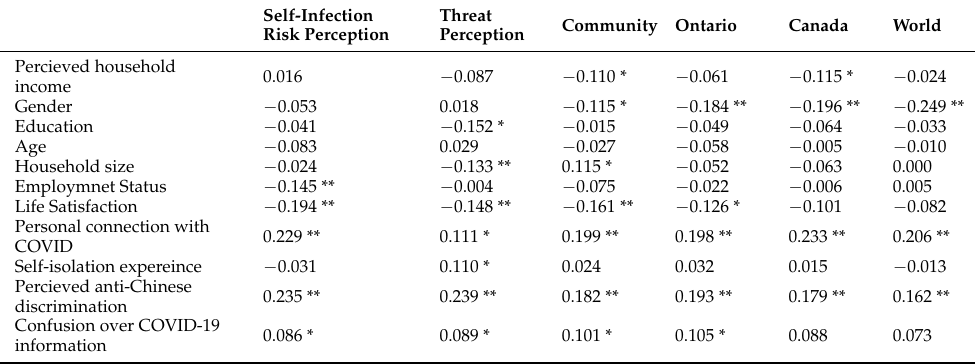
Table 3. Correlations between predictor and outcome variables in the final model.